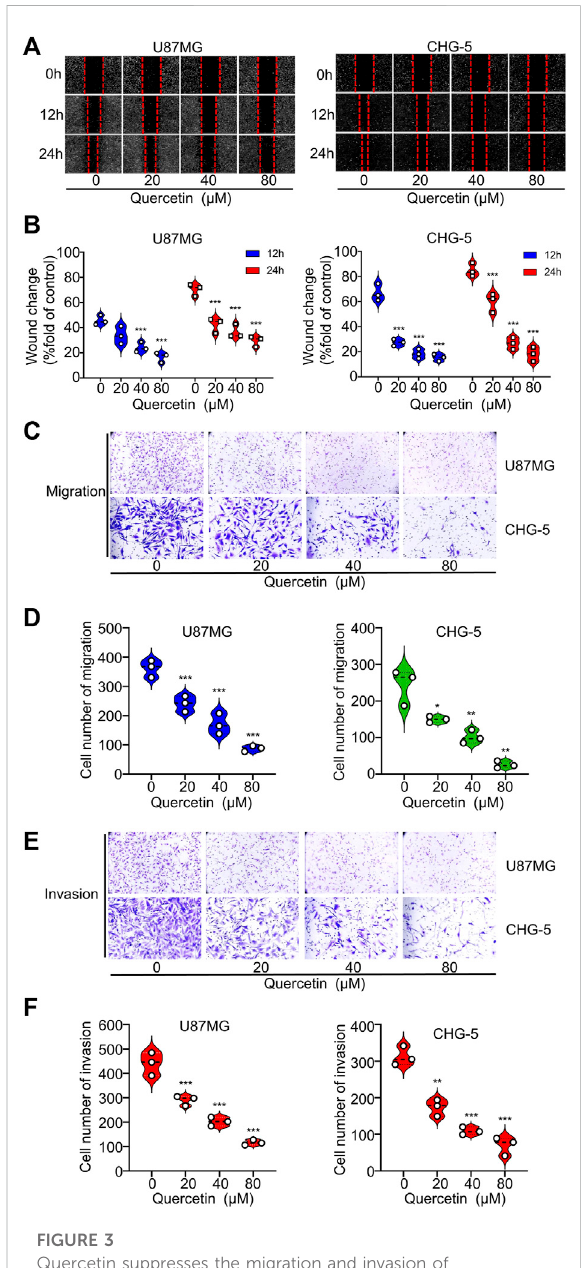
FIGURE 3 Quercetin suppresses the migration and invasion